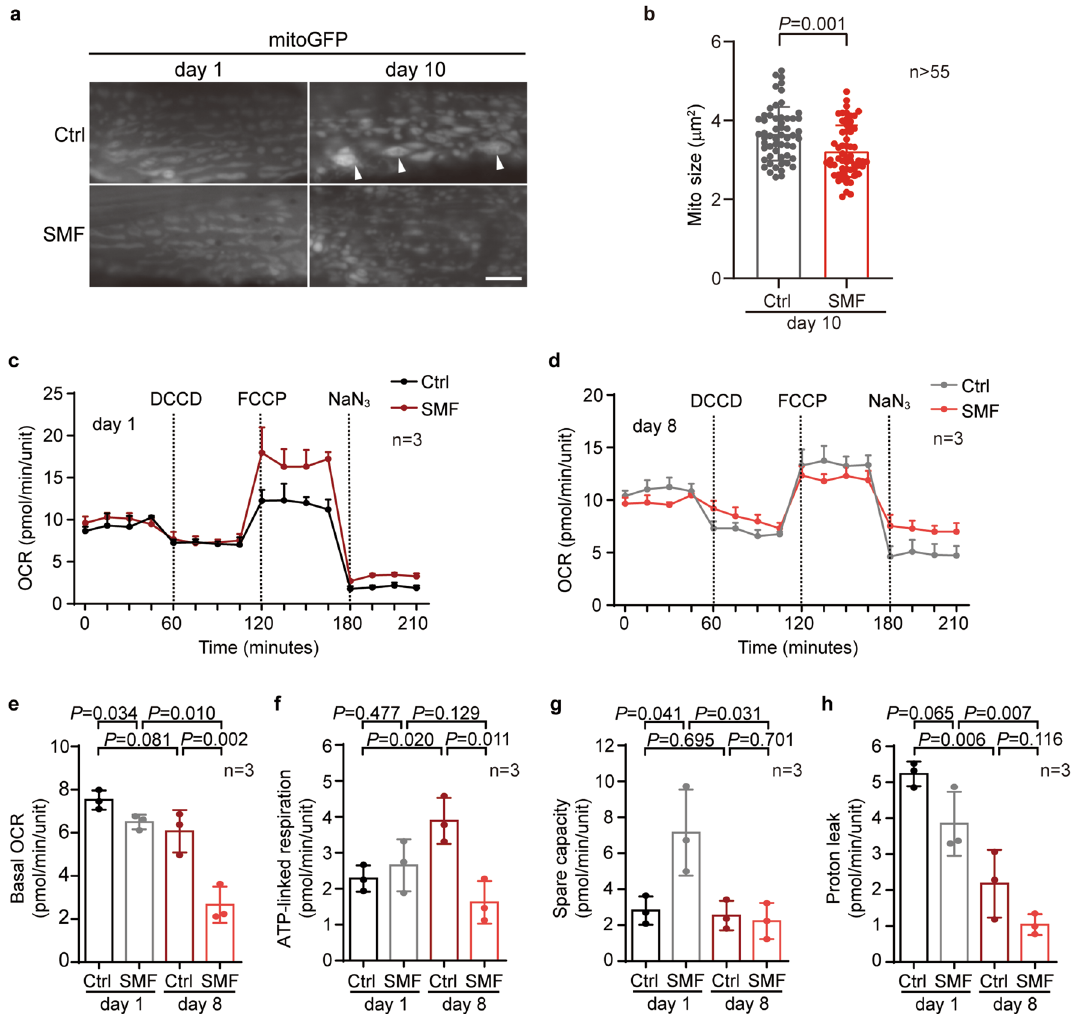
Figure 2. Mitochondria is under the regulation of the static magnetic field. ( a ) SMF of 10 mT regulates the ageing-induced change of mitochondrial morphology. Mitochondria in body wall muscle were examined at indicated ages. Arrowheads denote representative swollen mitochondria. Scale Bar: 2 μm. ( b ) SMF reduces the average sizes of mitochondria in body wall muscle at day 10 of adulthood. Unpaired t -test. ( c ) and ( d ) Seahorse Mito Stress Test in worms treated with SMF at indicated ages. ( e )–( h ). Four benchmarks of mitochondrial function, namely basal OCR ( e ), ATP-linked respiration ( f ), spare capacity ( g ), and proton leak ( h ) in Ctrl or SMF-treated worms at indicated ages. Unpaired t